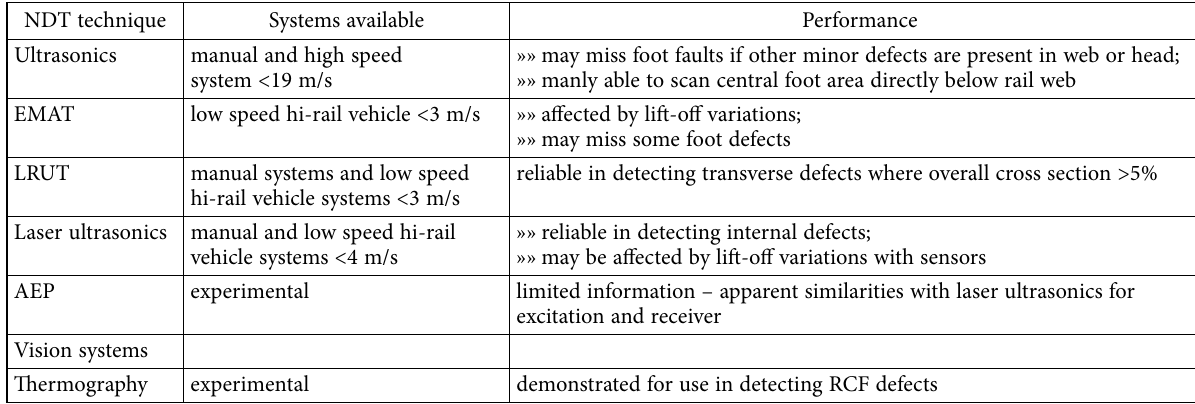
Table 1. Defect detection techniques applicable to the rail